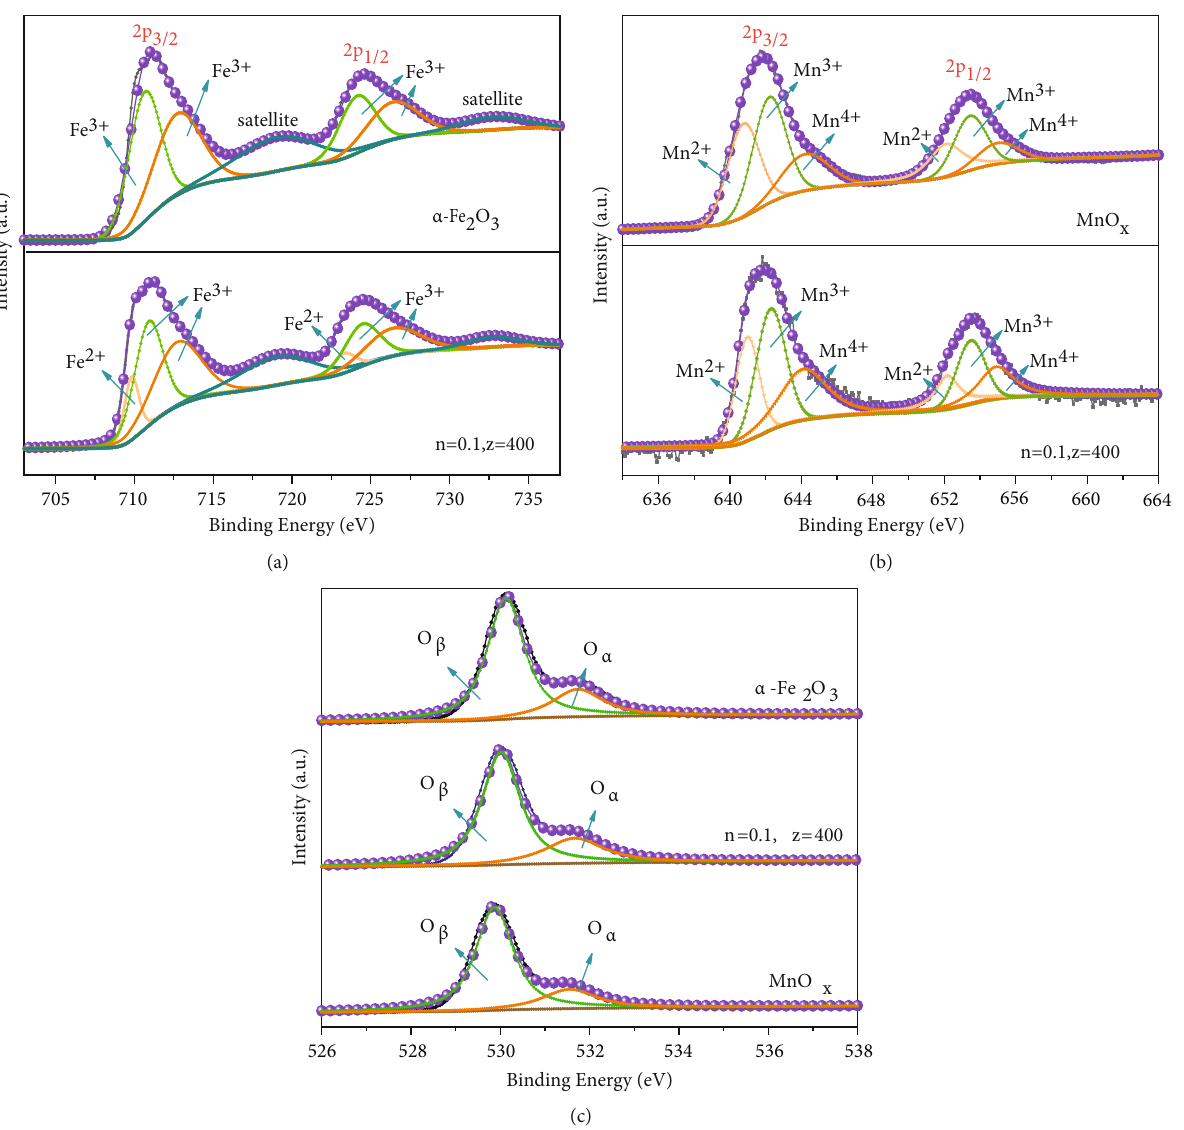
O (400), MnO (400) and MnO 2 3 x